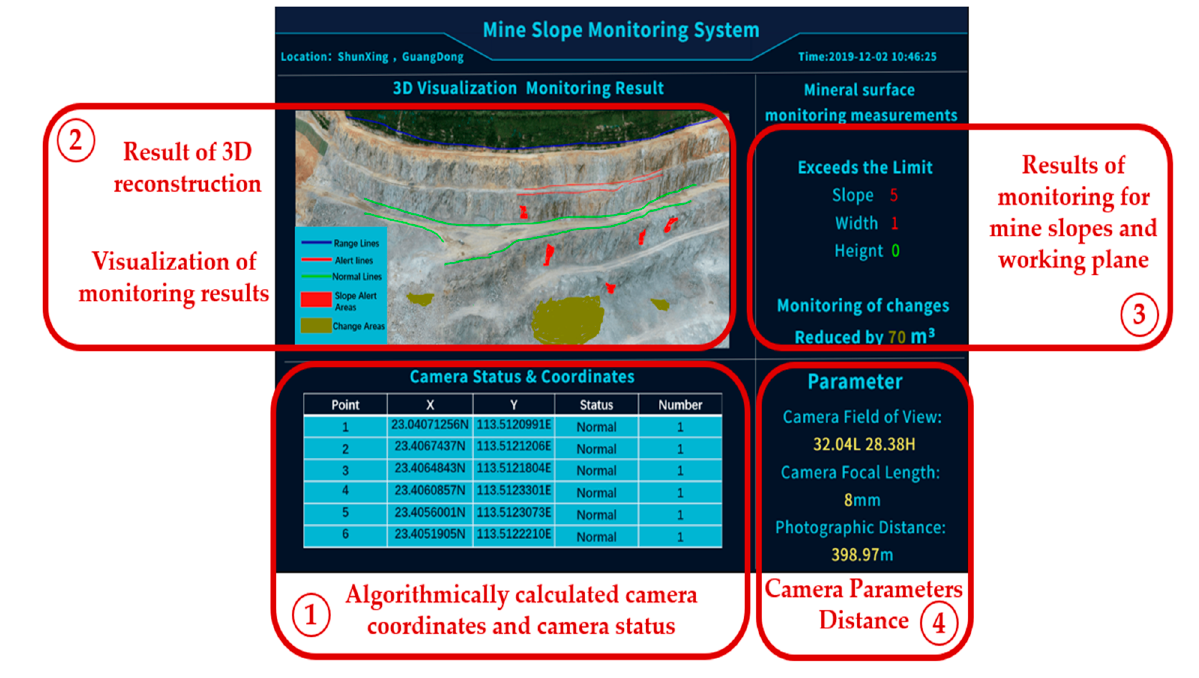
Figure 14. Software interfaces of the demonstration system. Table 3. Camera coordinates for the 6 different monitoring points shown in Figure 13.